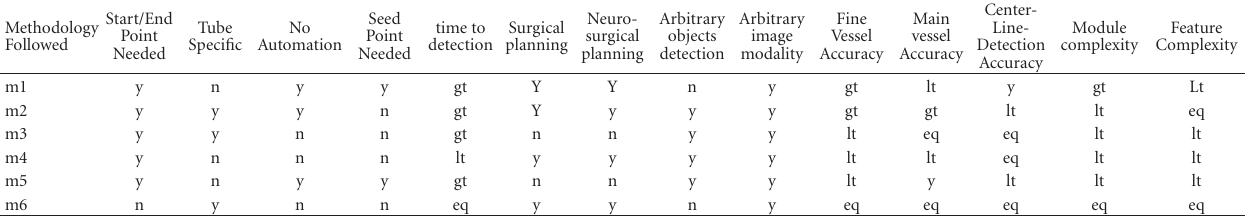
Table 2: Comparative analysis of the main vessel detection techniques with the proposed one. Methodology